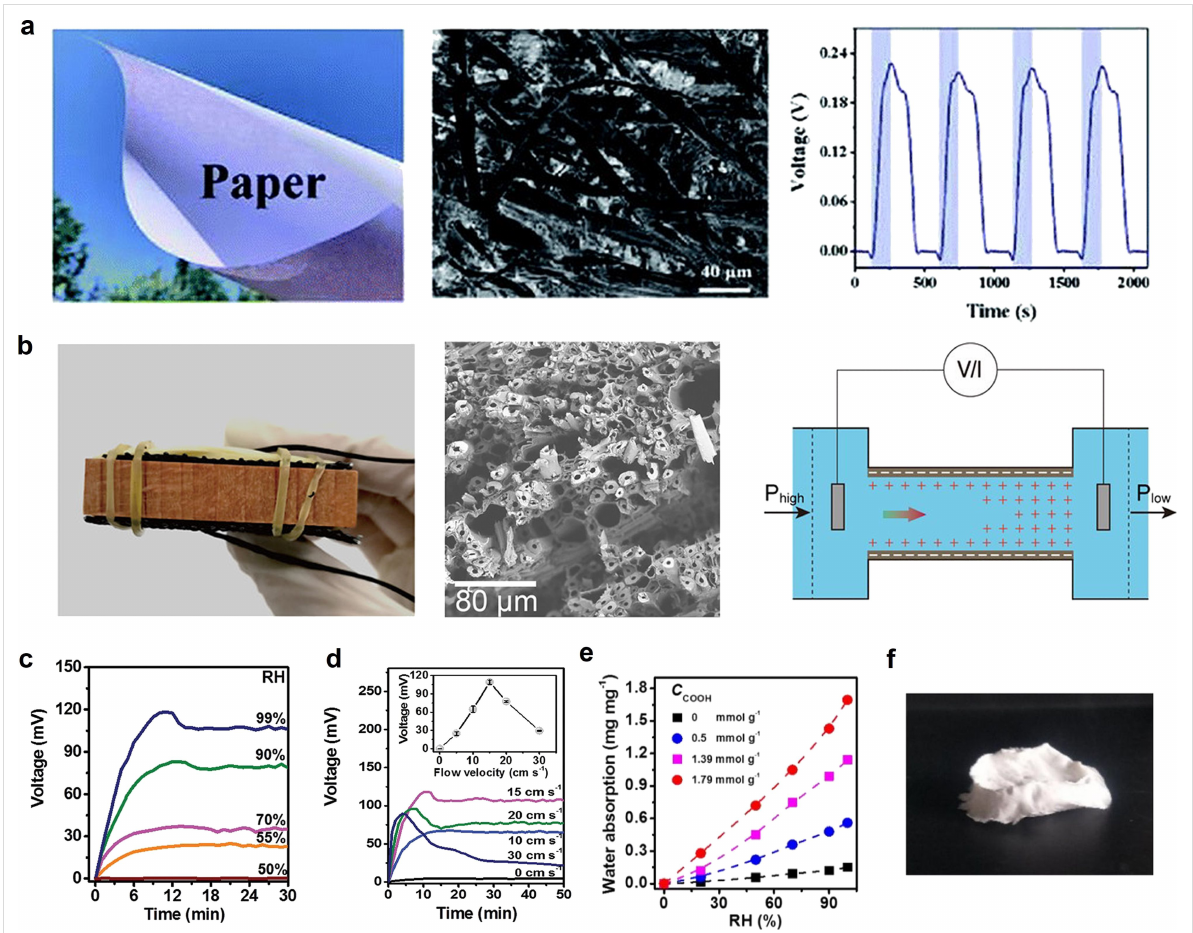
Figure 7: (a) From left to right: a photo of a sheet of paper, a SEM image of a paper sheet, and the voltage generated by moisture on the paper. Figure 7a was republished with permission of The Royal Society of Chemistry from [79] (“Electric power generation using paper materials” by Gao, Xue et al., Journal of Materials Chemistry A., vol. 7, issue 36, © 2019); permission conveyed through Copyright Clearance Center, Inc. This content is not subject to CC BY 4.0. (b) A picture of a wood nanogenerator, a SEM image of beech wood, and a schematic illustration of the device are shown from left to right. Figure 7b was reprinted with permission from [81], Copyright 2020 American Chemical Society. This content is not subject to CC BY 4.0. (c) V OC variation upon exposure to air flow at different RH values, flow velocity: 15 cm·s − 1 . (d) V OC variation upon exposure to air flow with differ- ent velocities, RH: 99%. (e, f) Water absorption of samples with different hydroxy group content and structural collapse of samples with high hydroxy group content. Figure 7c–f were reproduced from [80], Li, Mingjie et al., “Biological Nanofibrous Generator for Electricity Harvest from Moist Air Flow”, Adv. Funct. Mater., with permission from John Wiley and Sons. Copyright © 2019 WILEY-VCH Verlag GmbH & Co. KGaA, Weinheim. This content is not subject to CC BY